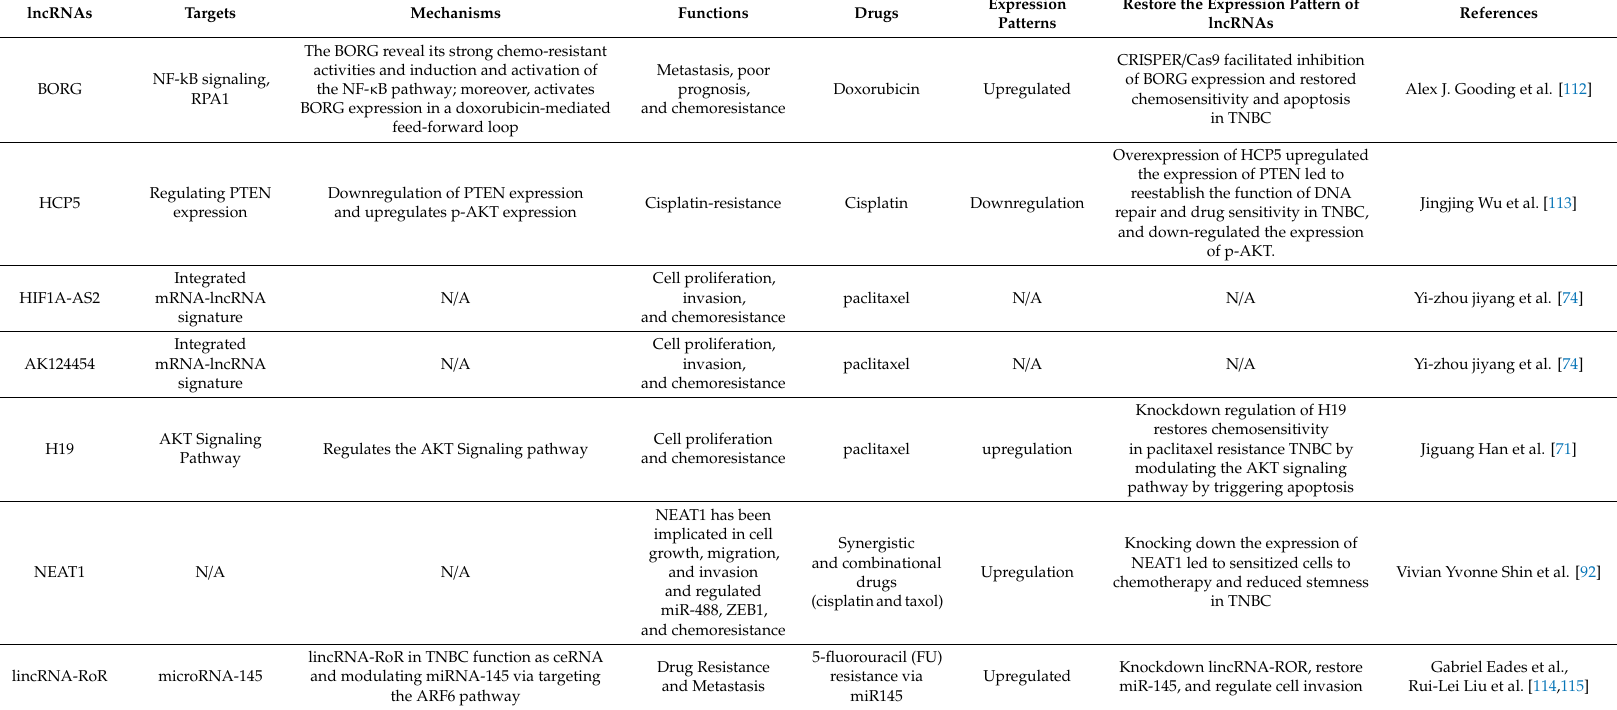
Table 1. Details of triple-negative breast cancer (TNBC)-associated long non-coding (lnc)RNAs and their roles in chemoresistance in TNBC are given in the table.